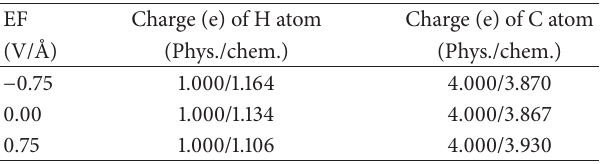
Table 2: H and C atomic charges (in electrons) for hydrogen physisorption or chemisorption (phys./chem.) under influence of three intensities of electric field